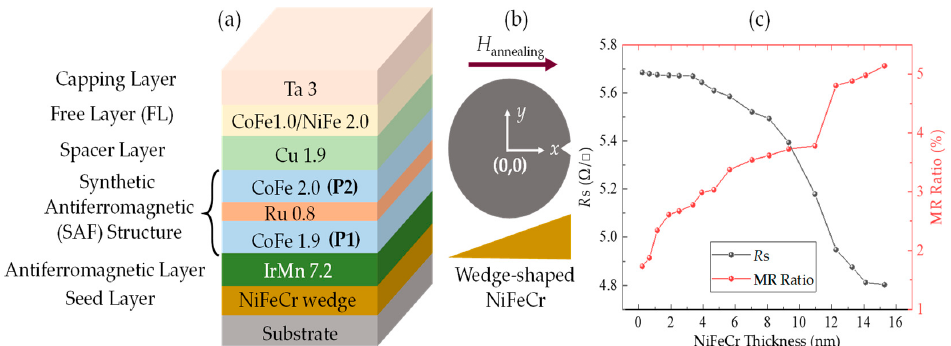
Figure 1. ( a ) Schematic of the film stack, ( b ) schematic of the wedge-shaped seed layer on the wafer, ( c ) sheet resistance and MR ratio of the film versus NiFeCr thickness. ( c ) sheet resistance and MR ratio of the film versus NiFeCr